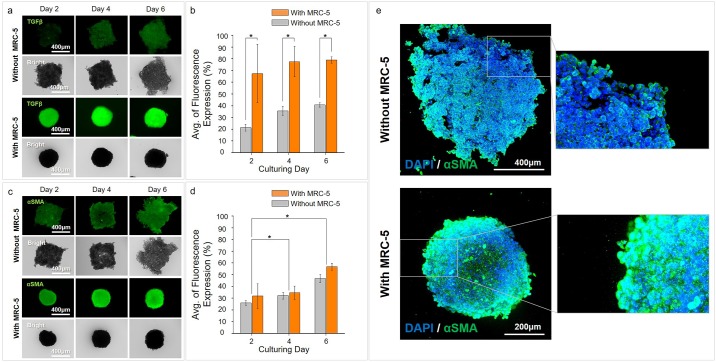
High expression of αSMA, a myofibroblast marker, through TGFβ activation by fibroblasts in MCTs.(a, b) TGFβ expressions without and with the MRC–5 groups on the CLF concave microwell array. (c, d) αSMA expression without and with the MRC–5 groups on the CLF concave microwell array. (e) Confocal images confirm the expression of αSMA. p < 0.05(*).